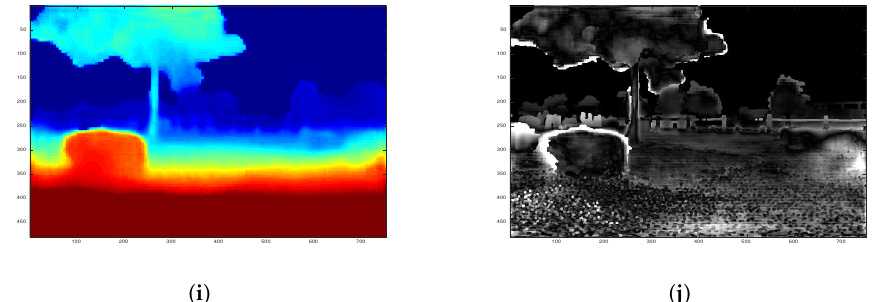
Figure 8. One qualitative result for stereo-stereo fusion in real Trimbot2020 Garden Dataset. The lighter pixels in ( d , f , h , j ) represent larger disparity error. ( a ) ground truth; ( b ) intensity image; ( c ) FPGA SGM;